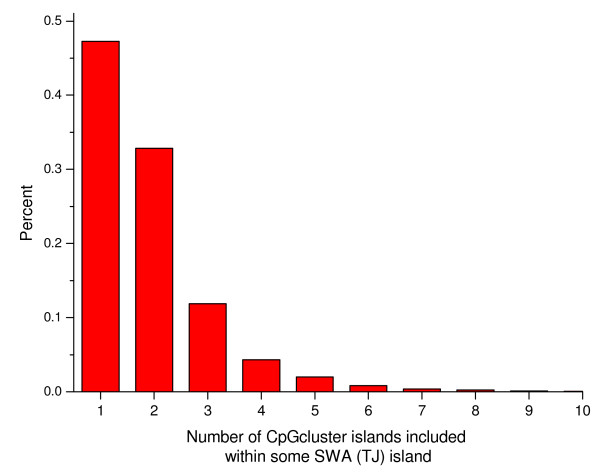
Distribution of the number of CpGcluster islands included within SWA (TJ) islands.